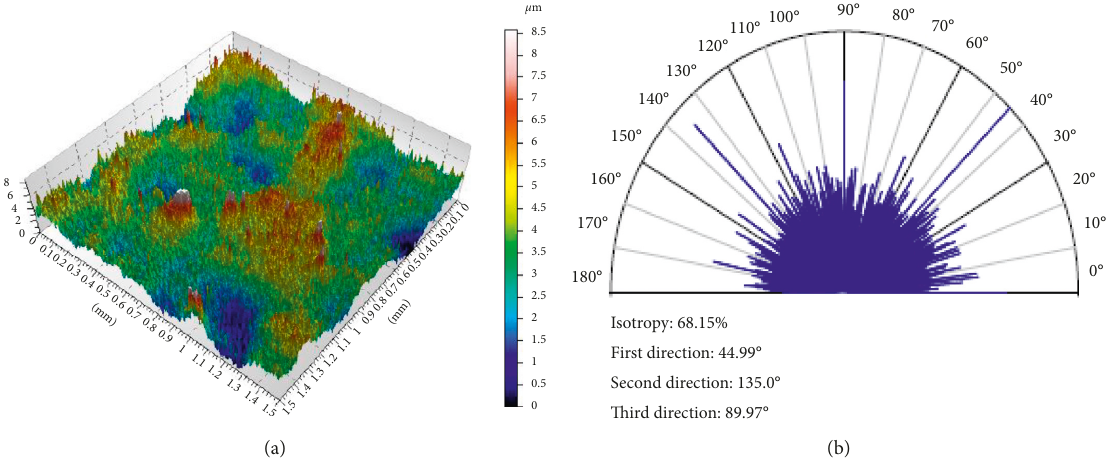
Figure 10: (a) 3D surface image of MoS 2 and (b) the polar graph with texture directions.